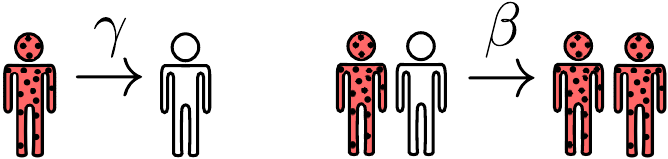
Figure 2. Susceptible-infected-susceptible model (SIS) transition events. Infected agents (red dotted) undergo recovery events with probability γ and change to susceptible (empty) health status. Infected agents may also infect additional susceptible agents with probability β , as long they are